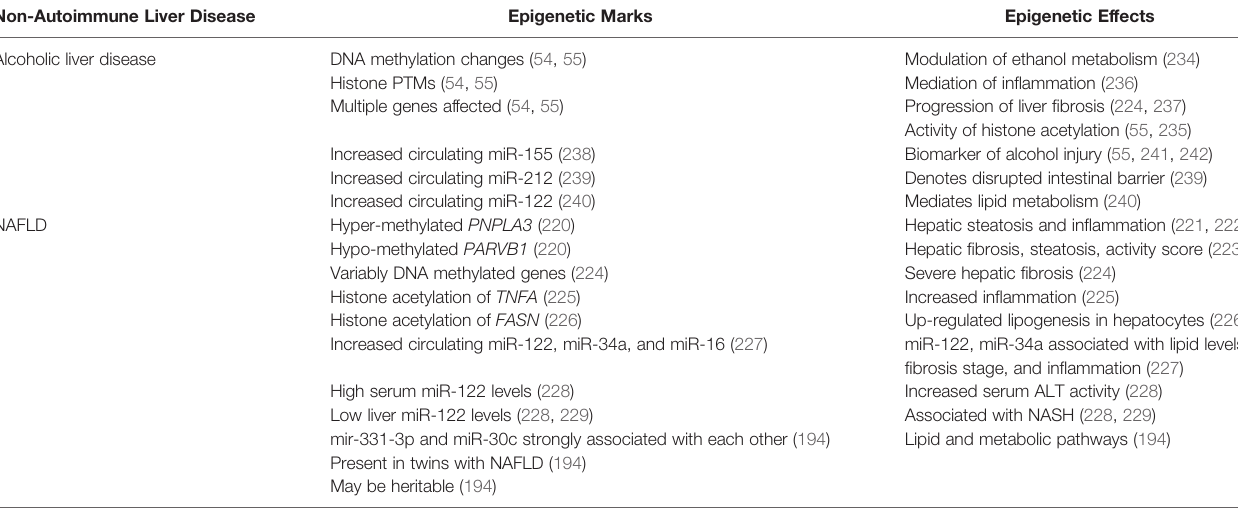
TABLE 4 | Epigenetic marks in non-autoimmune liver diseases. Non-Autoimmune Liver